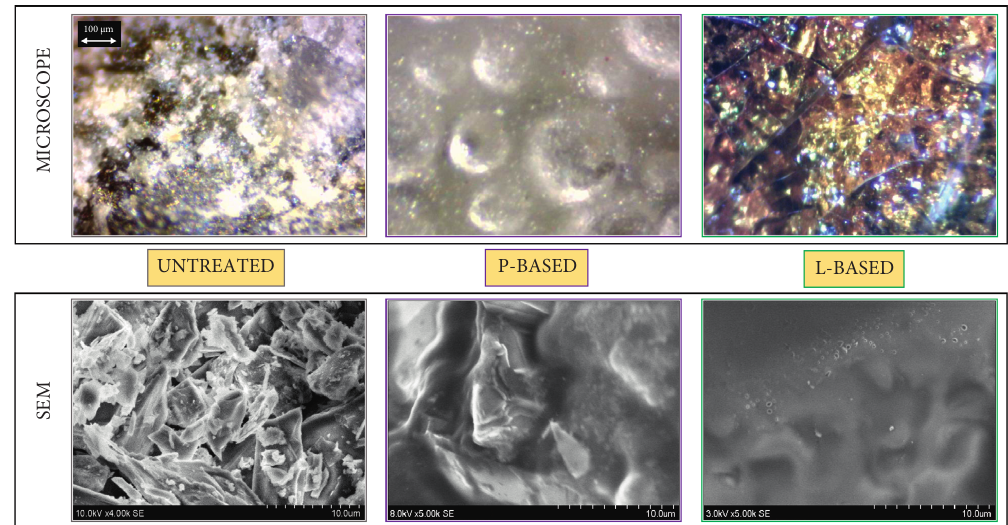
Figure 7: Appearance of the surface of crushed rock aggregates probed with the microscope (scale bar 100 µ m) and SEM (scale bar 10 µ